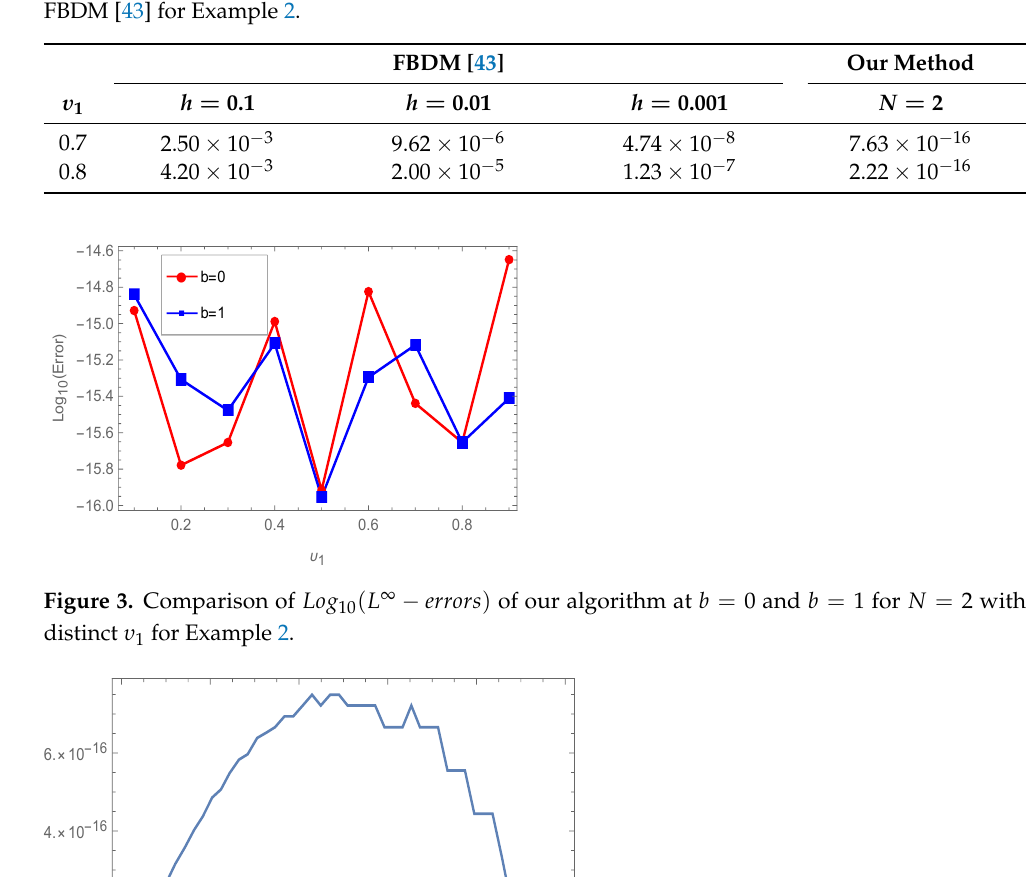
Table 4. Comparison of L ∞ -errors of our algorithm at υ 1 = 0.7,0.8 and b = 1 for N = 2 with the